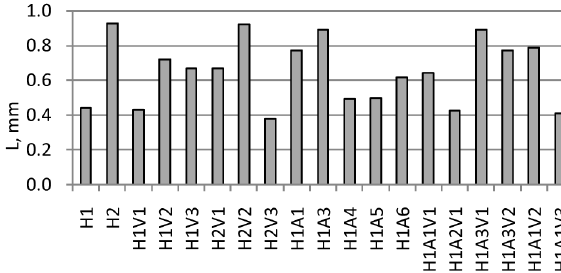
Fig. 1. The air-void volume of HPSCC (Łaźniewska- Piekarczyk 2013)